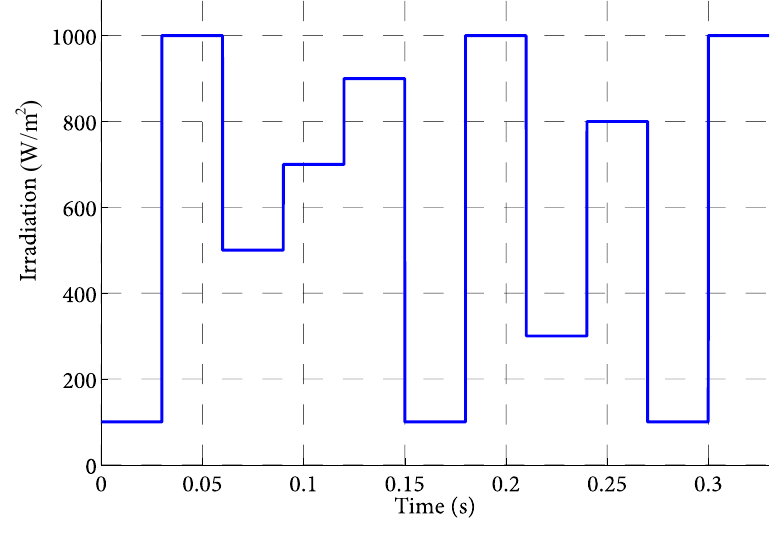
Figure 20. Variable irradiation.